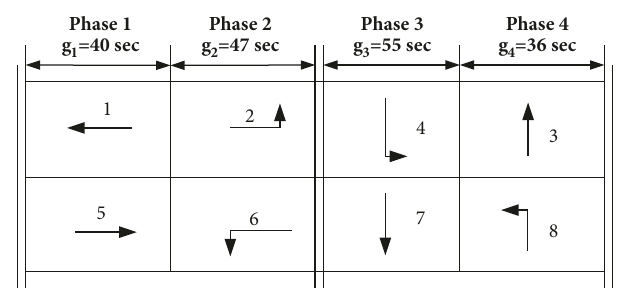
Figure 9: Adjusted signal timing.